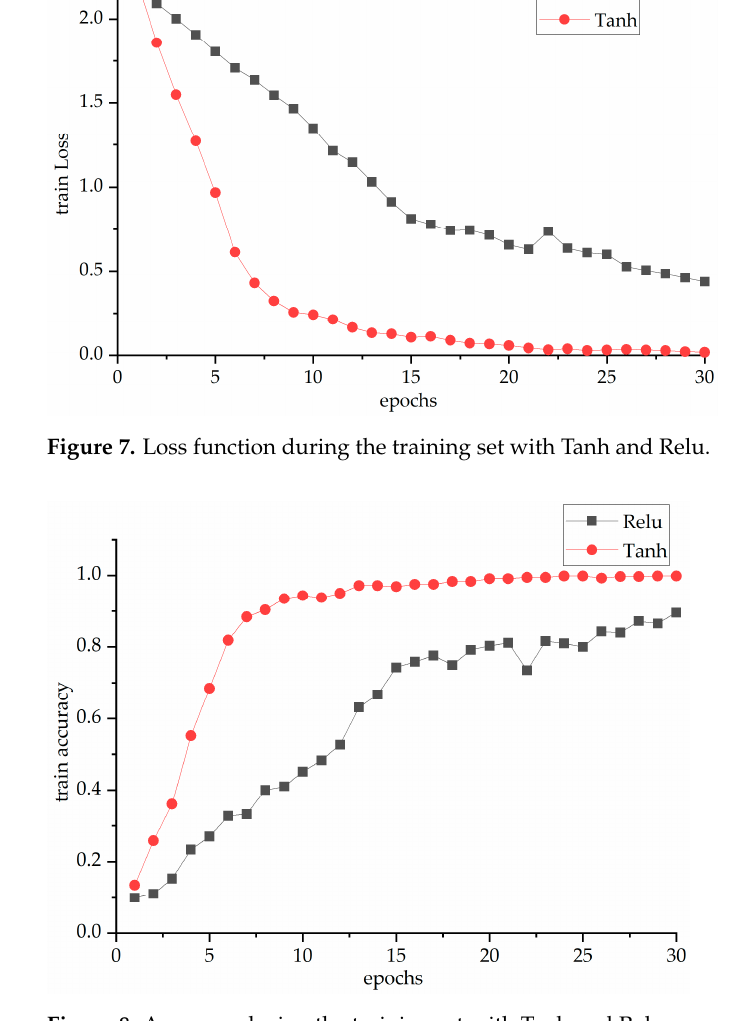
Figure 9. The influence of different activation functions on accuracy under different loads.